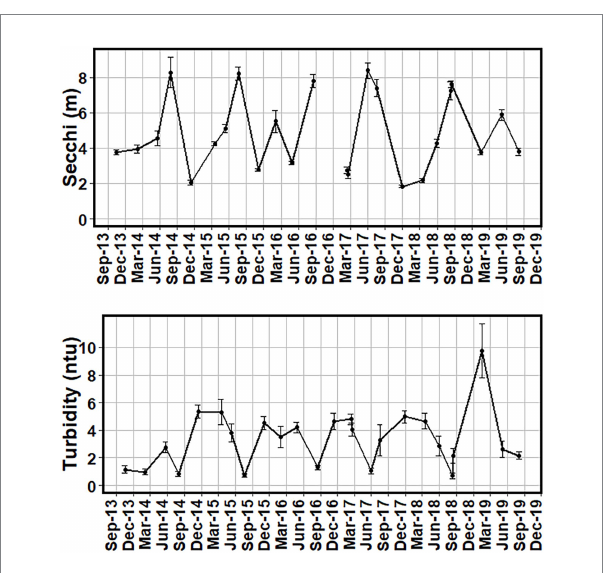
FIGURE 4 Mean Secchi disk depths in meters (m) and turbidity (ntu) from all sites between October 2013 and August 2019. The missing point is from November 2016 for the Secchi figure. Error bars of one standard error are added to show the variance of the values.